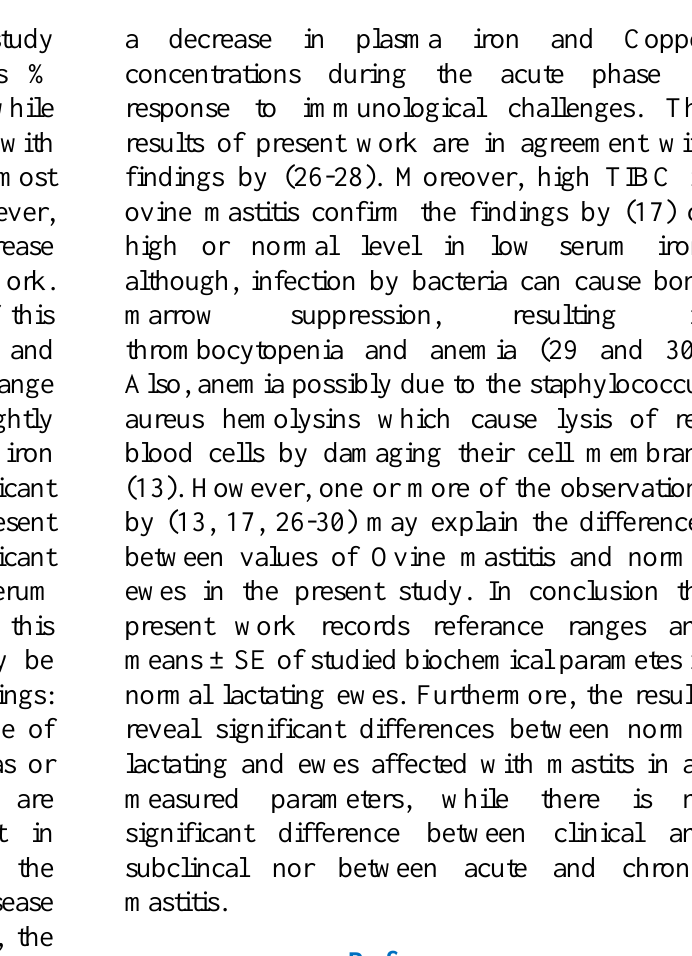
Table, 2: Serum Iron, TIBC, UIBC, Ts % and Copper in clinical and subclinical mastitis ( Ranges and Means ± SE ) Groups Clinical mastitis n=19 Subclinical mastitis n=31 Different small letter (a, b) vertically means significantly different at (P˂ 0.05). Table, 3: Serum Iron, TIBC, UIBC, Ts % and Copper in acute and chronic mastitis subgroups ( Means ± SE ) Groups Acute mastitis n=11 Different small letter (a, b) vertically means significantly different at (P˂